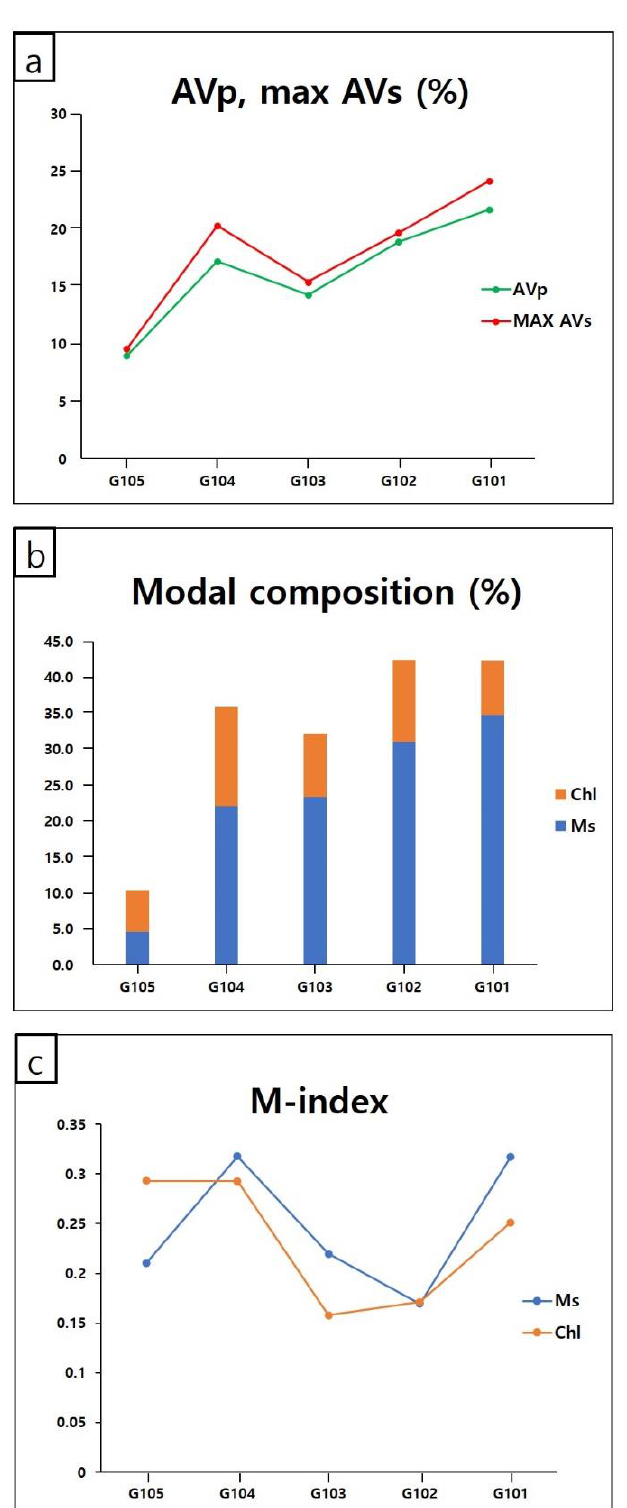
Figure 12. Whole rock seismic anisotropies depending on modal compositions and fabric strengths of phyllosilicates. The order of samples follows the increasing volume proportion of muscovite. ( a ) anisotropy of P-wave (AVp) and maximum anisotropy of S-wave (max. AVs) for each sample. ( b ) Modal composition of muscovite and chlorite for each sample. ( c ) M-index indicating fabric strengths for each mineral. Ms: muscovite; Chl: chlorite.